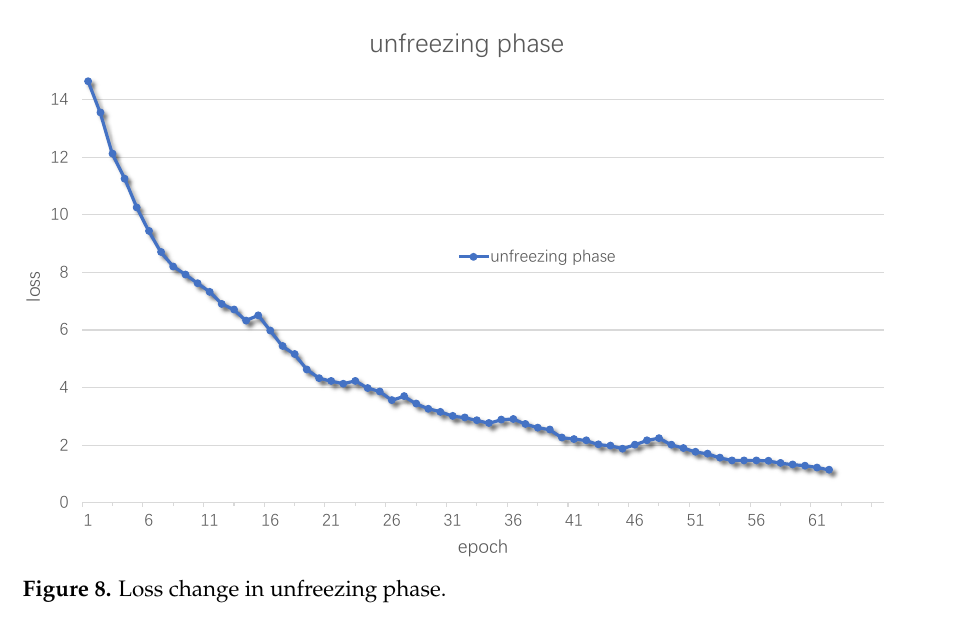
Figure 7. Loss change in freezing phase.